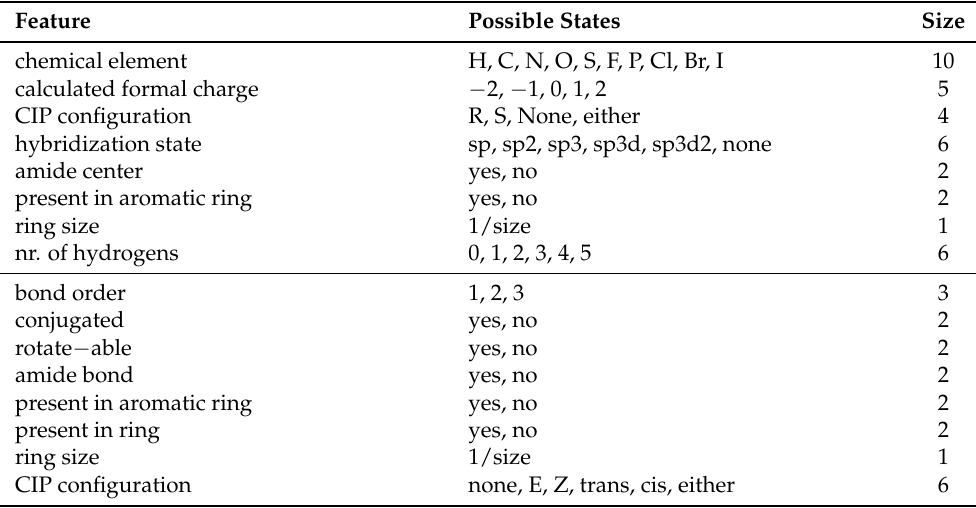
Table A1. Node and edge featurization of type 3. Each node or edge featurization vector consisted of a concatenation of the different one-hot encoded or floating point feature vectors according to their possible states (if present) and corresponding size-36 for nodes and 20 for